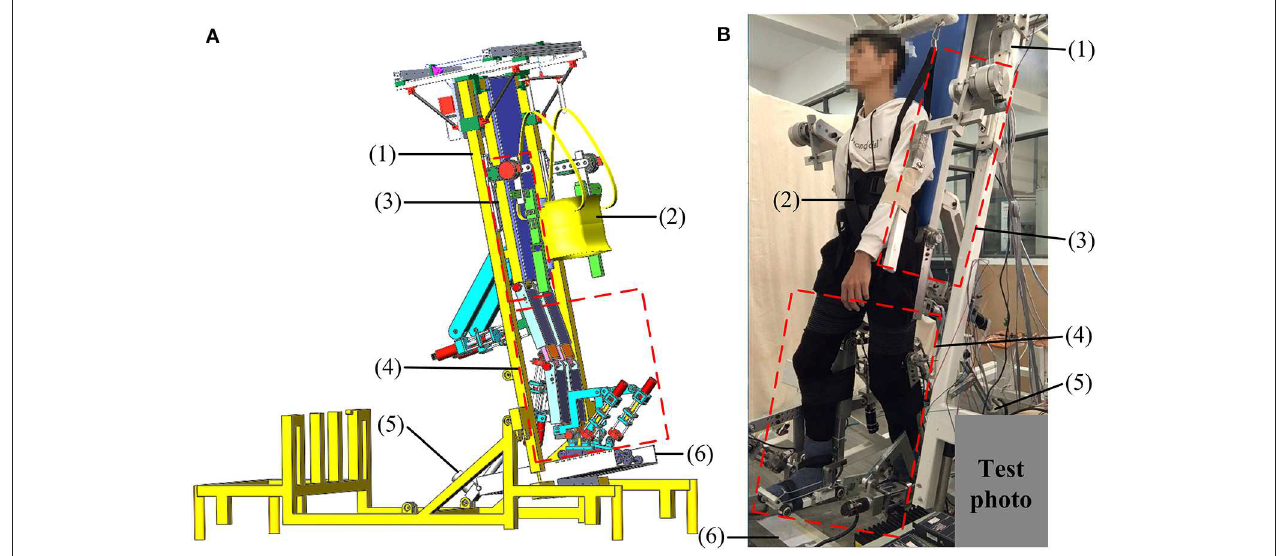
FIGURE 1 | The ROWAS II system: (A) the CAD model and (B) the prototype with a test participant. (1) Bed frame, (2) BWS system, (3) mechanism for the upper limb, (4) mechanisms for the lower limbs, (5) linear actuator, and (6) ground-simulation plate. Adapted from our previous paper (Mu et al., 2019) with permission (license:4797140179422) from IEEE.